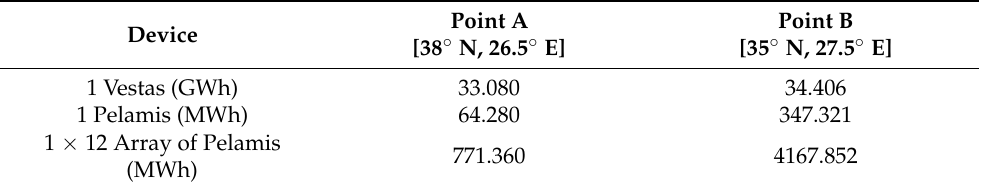
Table 5. Energy outputs of Vestas offshore wind turbine and Pelamis devices in best complementarity (A) and synergy (B)